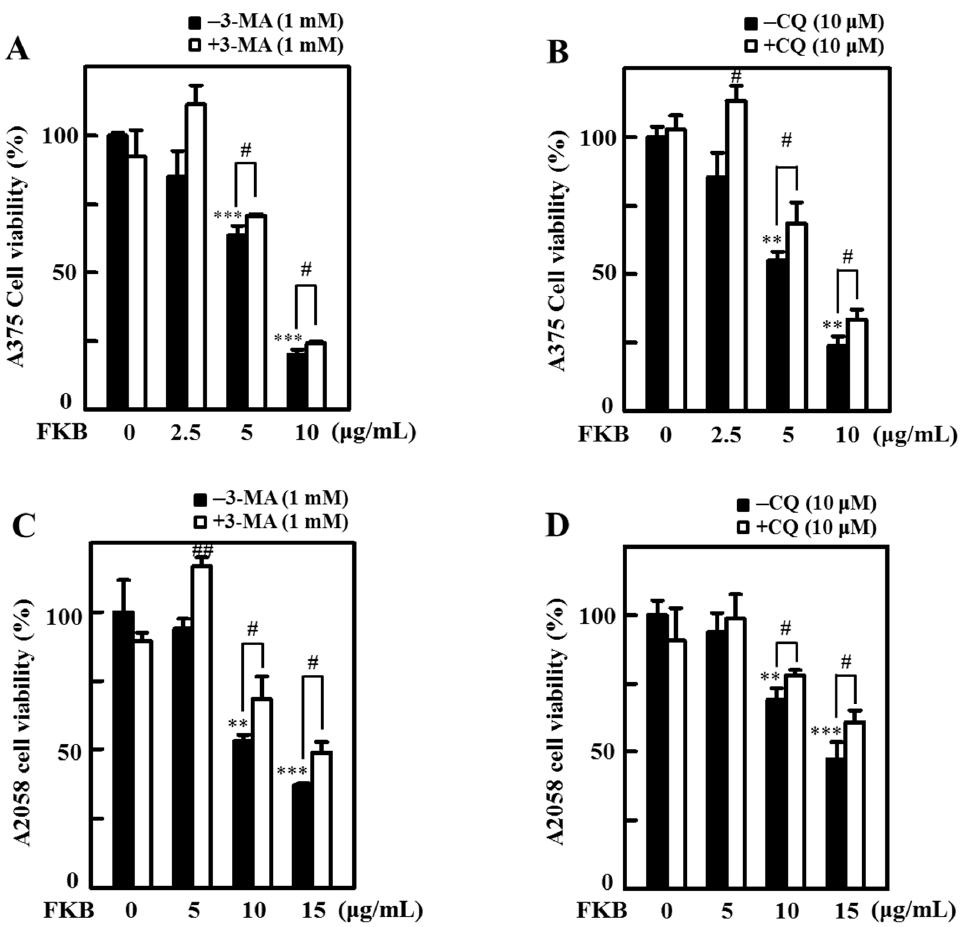
Figure 8. FKB induced autophagy signaling cascades mediated the cell death mechanisms in human melanoma cells. ( A , B ) A375 and ( C , D ) A2058 cells were pretreated with early and late autophagy inhibitors (1 mM 3-MA, and 10 µM CQ) for 1 h followed by FKB (0–10 or 0–15 µg/mL) treatment,